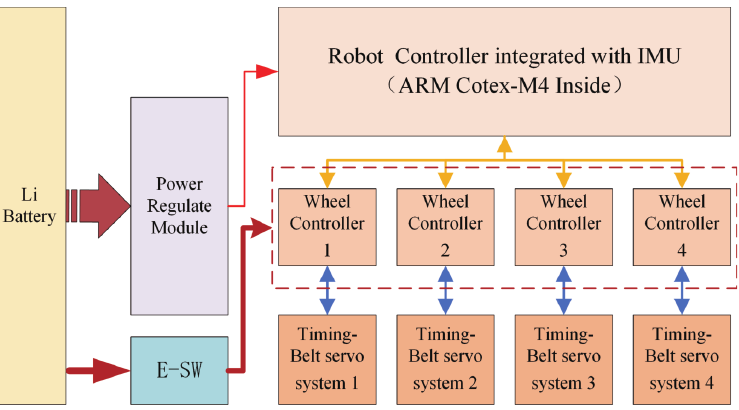
Figure 6. The block diagram of the mobile robot control system. The parameters of the proposed controller design in this paper are shown in Table 1. Table 1. The key parameters of the mobile robot.